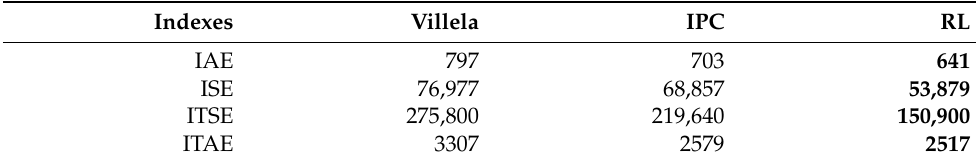
Table 1. Performance indexes X p = − 80 cm, Y p = 40 cm.